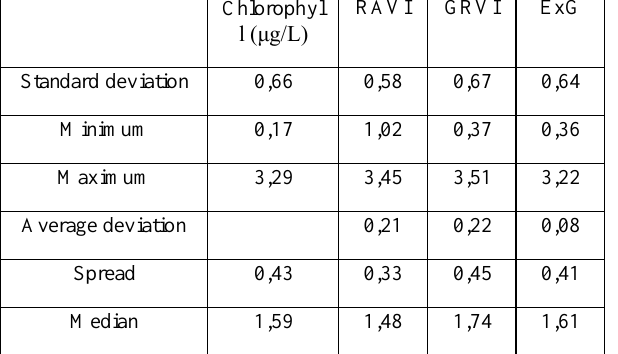
Table 2 Evaluating the quality of derived relationships